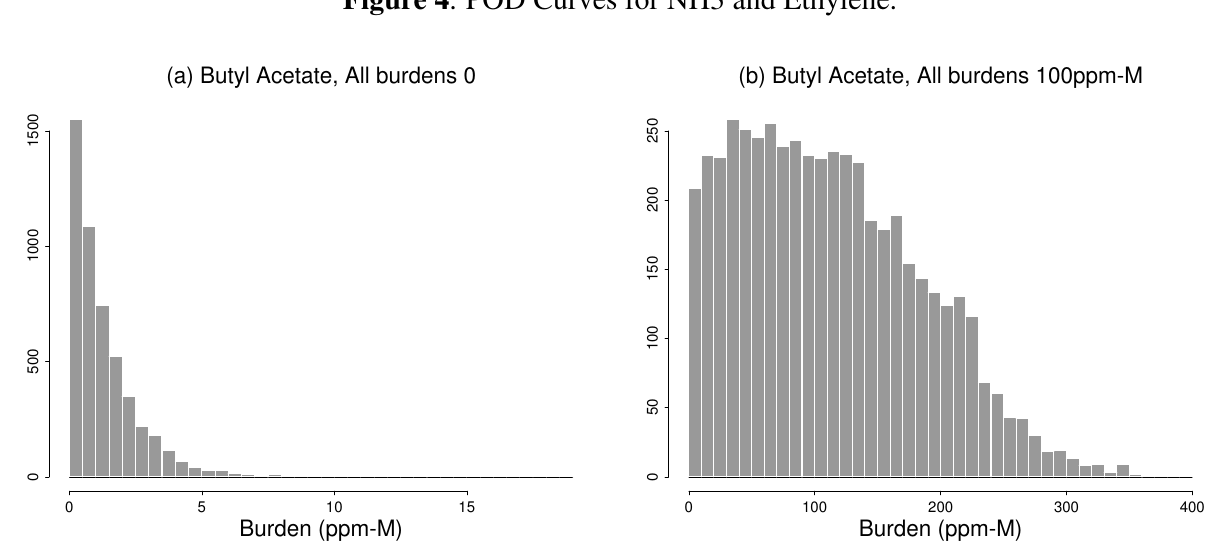
Figure 4 . POD Curves for NH3 and Ethylene.